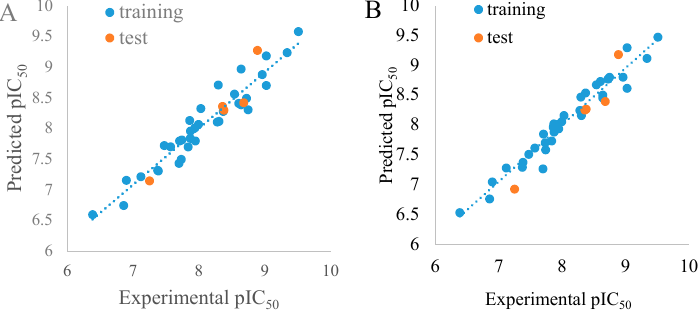
Figure 3. Plots of experimental vs. predicted pIC 50 values for the total set in the CoMFA ( A ) and CoMSIA ( B ) models.